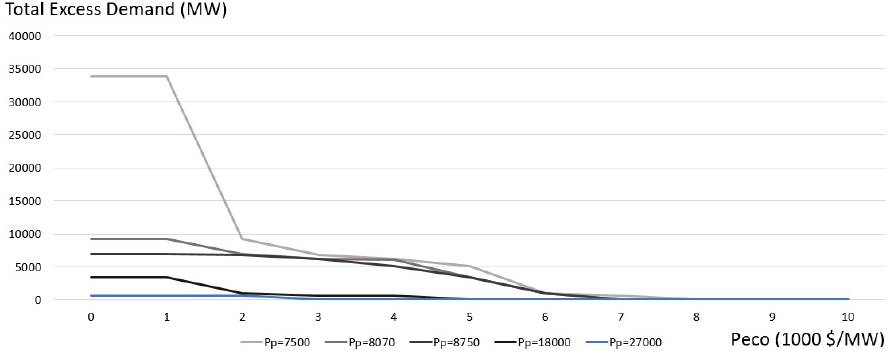
Figure 7. Variation of the total excess demand with respect to P eco and P p in case of certainty (own